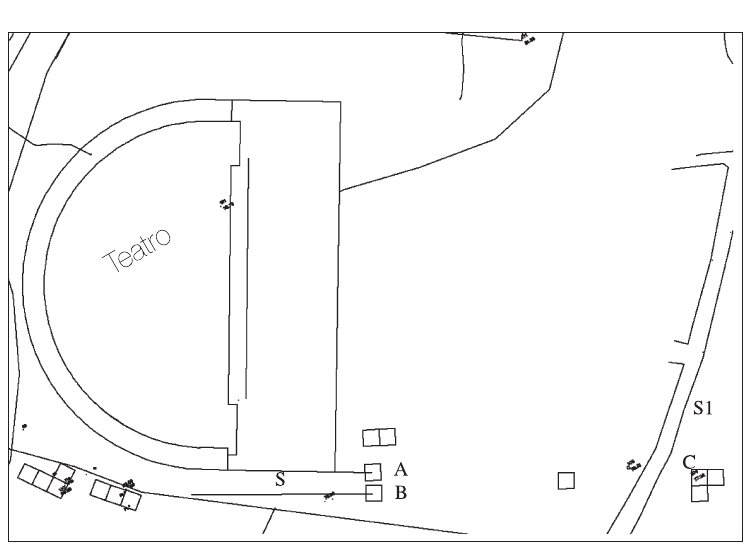
Fig. 10. Plan of the area of the Roman theatre of Cales .